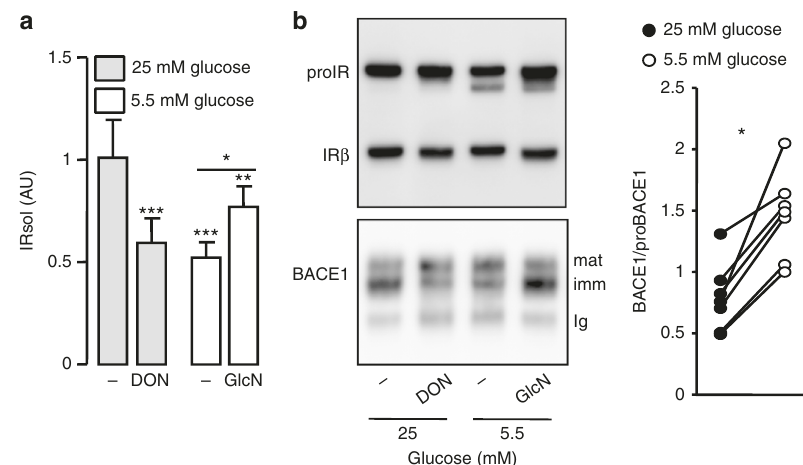
Fig. 5 Effect of glucose on IR cleavage and BACE1 expression. HEK 293 cells expressing IR and BACE1 were incubated for 24 h in media containing the indicated glucose concentrations, in the absence ( − ) or presence of deoxynorleucine (DON; 5 mM) or glucosamine (GlcN; 1 mM) then: a IRsol accumulated in the media was measured by ELISA; b IR and BACE1 were analyzed by immunoblot in total cell lysate or after BACE1 immunoprecipitation, respectively. Positions of the heavy chain of the precipitating antibody (Ig), immature (imm), and mature (mat) BACE1 are indicated. The graph shows the ratios BACE1/proBACE1 obtained from the quanti fi cation of seven different experiments; data from the same experiment are connected by a line. Data are means ± s.d. Statistical analyses were made using ANOVA, followed by Bonferonni ’ s test ( a ) and unpaired t -test ( b ). * p < 0.05; *** p <